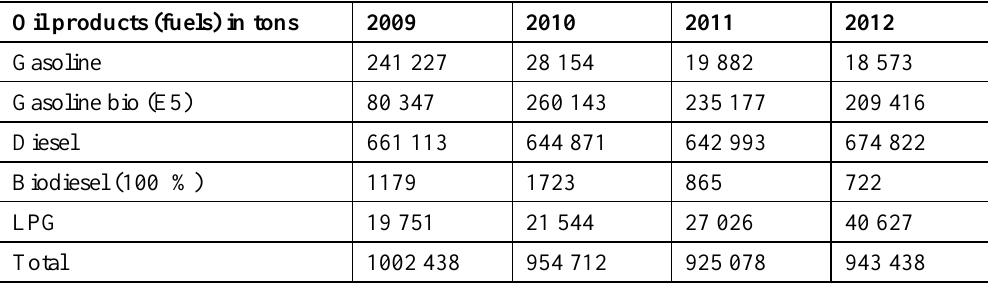
Source: Information from the State Revenue Service of Republic of